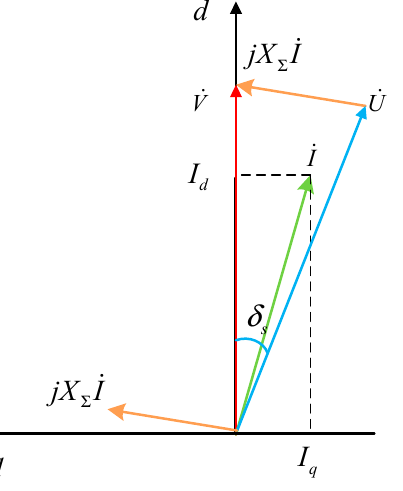
Figure 5. Vector diagram of stable system operation.